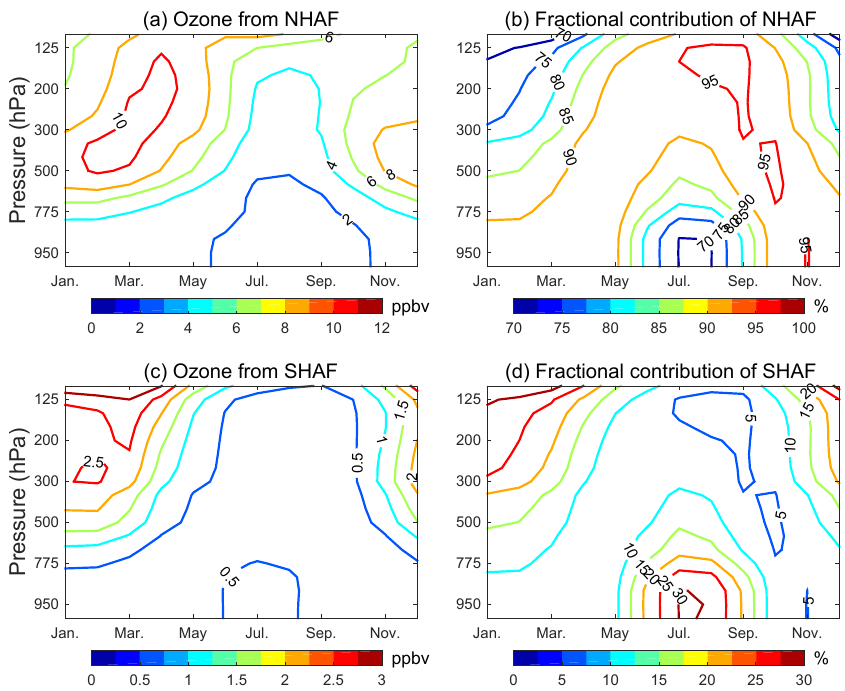
Figure 15. Seasonal altitude variations of imported African ozone (in ppbv) from (a) NHAF and (c) SHAF over Asia (60–145 ◦ E, 5–40 ◦ N; see Fig. 1) and the fractional contribution of ozone from (b) NHAF and (d) SHAF to the total imported African ozone over Asia (in %). The ozone values are the means from the 20-year GEOS-Chem